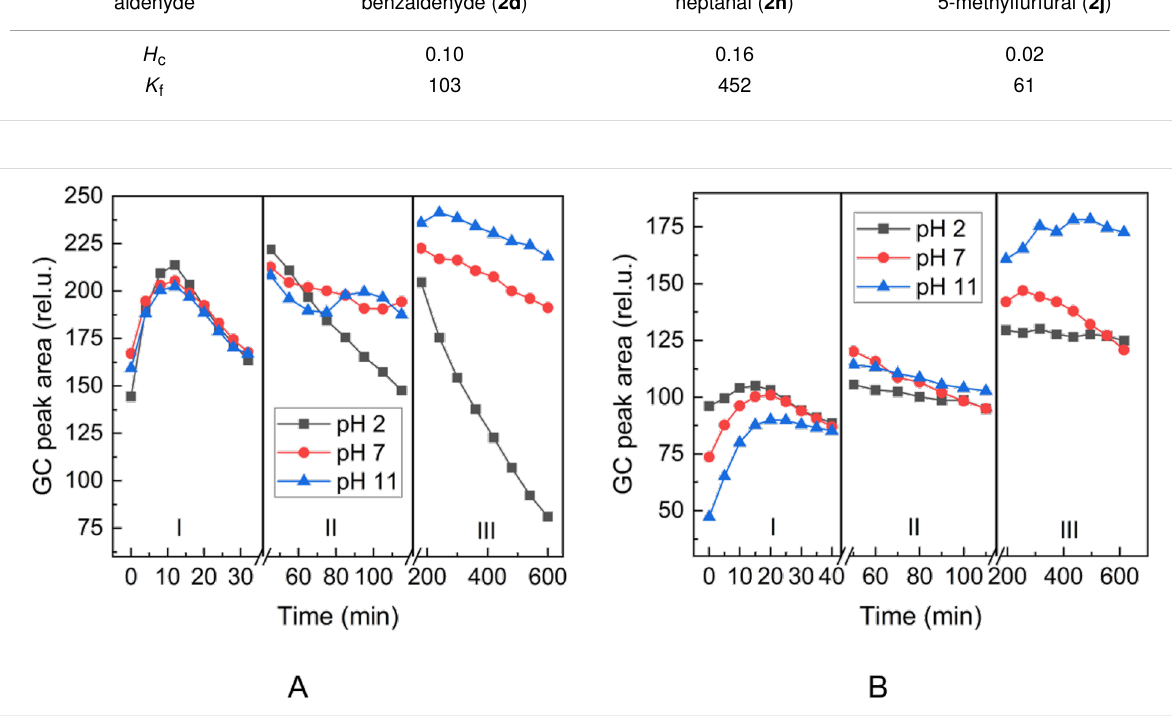
Figure 5: Time evolution of the headspace concentration of heptanal ( 2h ) after successive extractions from the gaseous phase above (A): heptanal ( 2h ) in aqueous phosphate buffers and (B): heptanylimino- β -CD ( 3h ) in aqueous phosphate buffers. Sampling intervals in the corresponding regions: I – 4 min (A) or 5 min (B), II – 10 min, III – 60